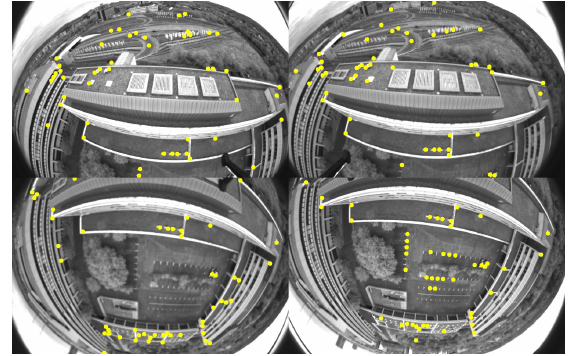
Figure 2: Example frame set taken with the four fisheye cameras in a synchronized way, that contains 50 feature points in each frame, which are tracked using the OpenCV implementation of the KLT